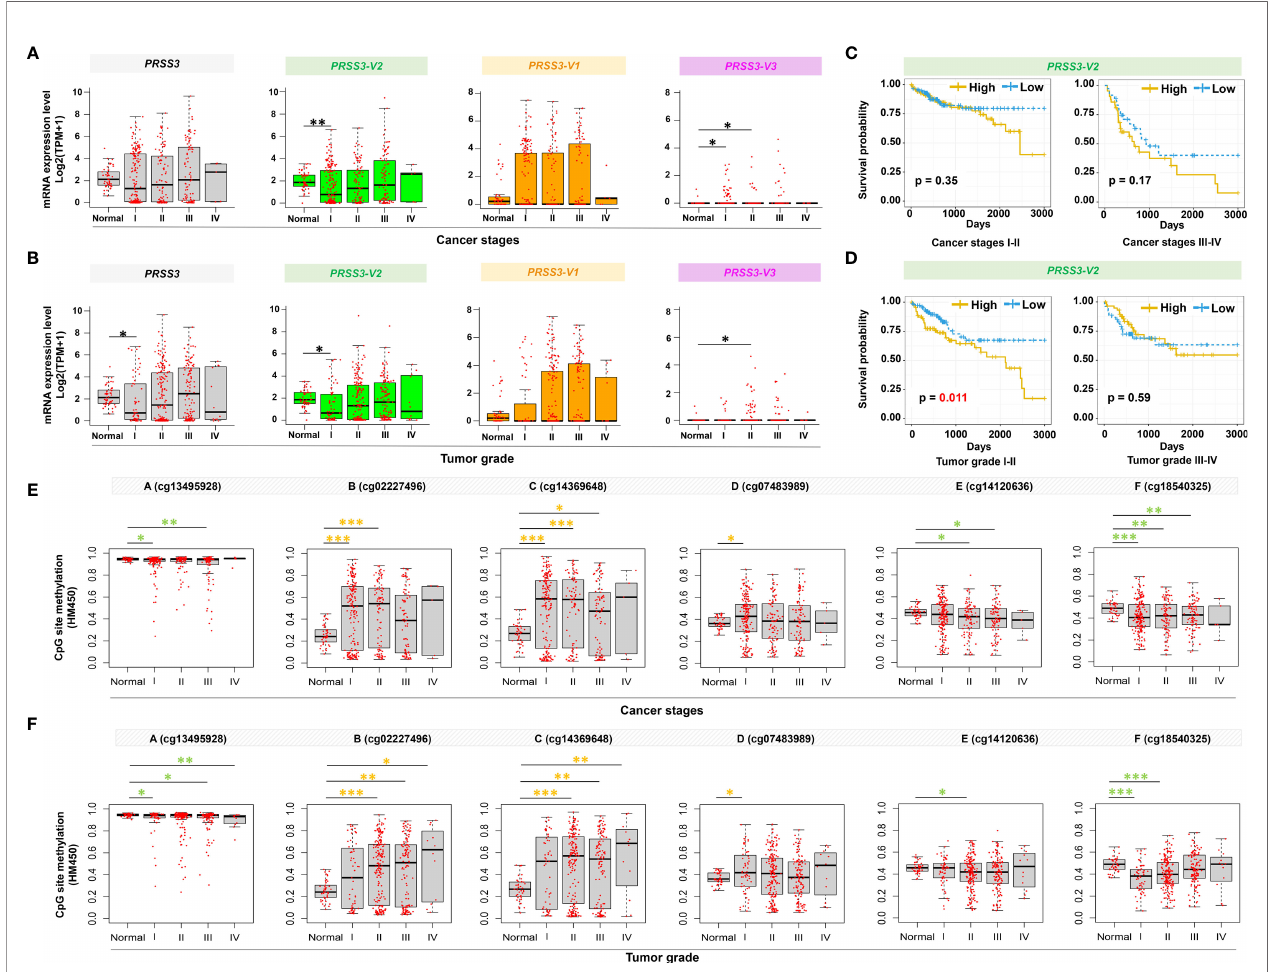
FIGURE 6 | Clinical relevance of epigenetic alteration of PRSS3-SVs in HCC patients. (A, B) Box-and-whisker plot with overlay of individual data points showing mRNA expression of PRSS3 transcripts in HCC tissues (Tumor=371) and normal controls (Normal=50), based on (A) cancer stages (171 stage I, 86 stage II, 85 stage IIII, 5 stage IV) and (B) tumor grades (55 grade I, 177 grade II, 122 grade III, 12 grade IV) ( Table 1 ). (C, D) HCC patients were grouped into PRSS3-V2 High and PRSS3-V2 Low groups based on the mean value of each transcript in tumors ( Table 1 ). The Kaplan – Meier method was used to determine patient survival, and the log-rank (Mantel – Cox) test was used to compare survival rates. The results of HCC patient survival curves from left to right panels: cancer stages I-II and III-IV (C) , tumor grades I-II and tumor grades III-IV (D) . (E, F) The association of methylation of CpG sites (A – F) within the extended fragment with different clinical stages (E) and pathological grades (F) in HCC tissue specimens (n=414) in comparison with normal liver control tissues (Normal=41). The data were extracted from the FIREHOSE. Statistical signi fi cance was determined by the Wilcoxon rank sum test. Asterisks in green and yellow indicate the changes in hypermethylation and hypomethylation, respectively. * P < 0.05, ** P < 0.01, *** P <